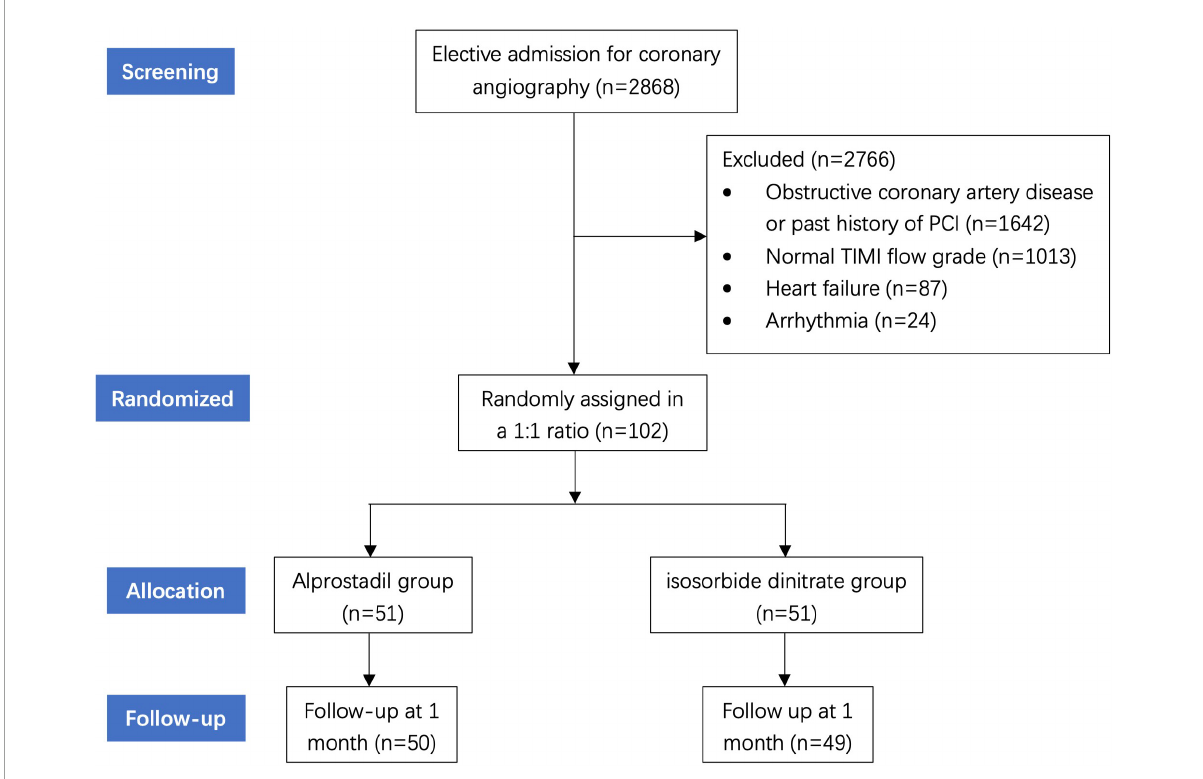
FIGURE1 The flowchart diagram of the